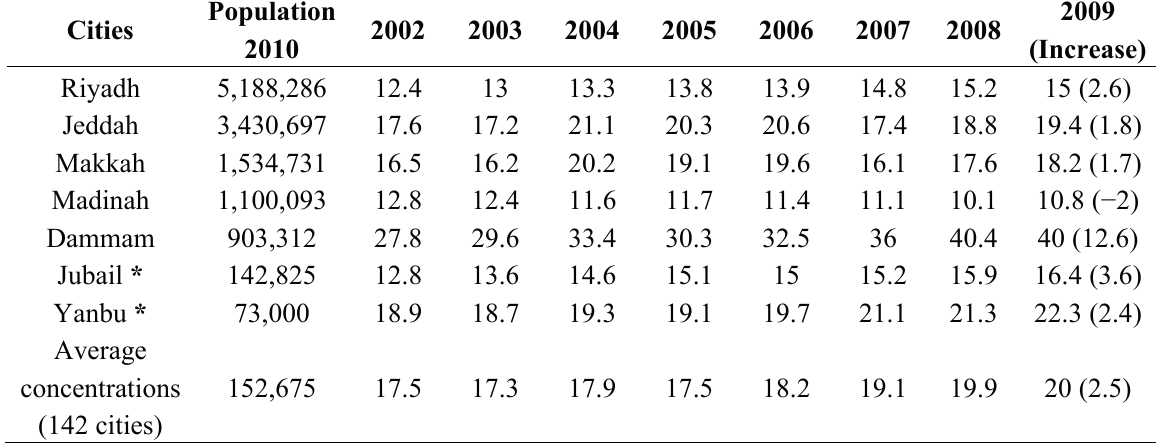
Table 2. PM 2.5 concentrations (un-weighted) (3 year moving average) (in µg/m 3 ) in selected cities. Cities